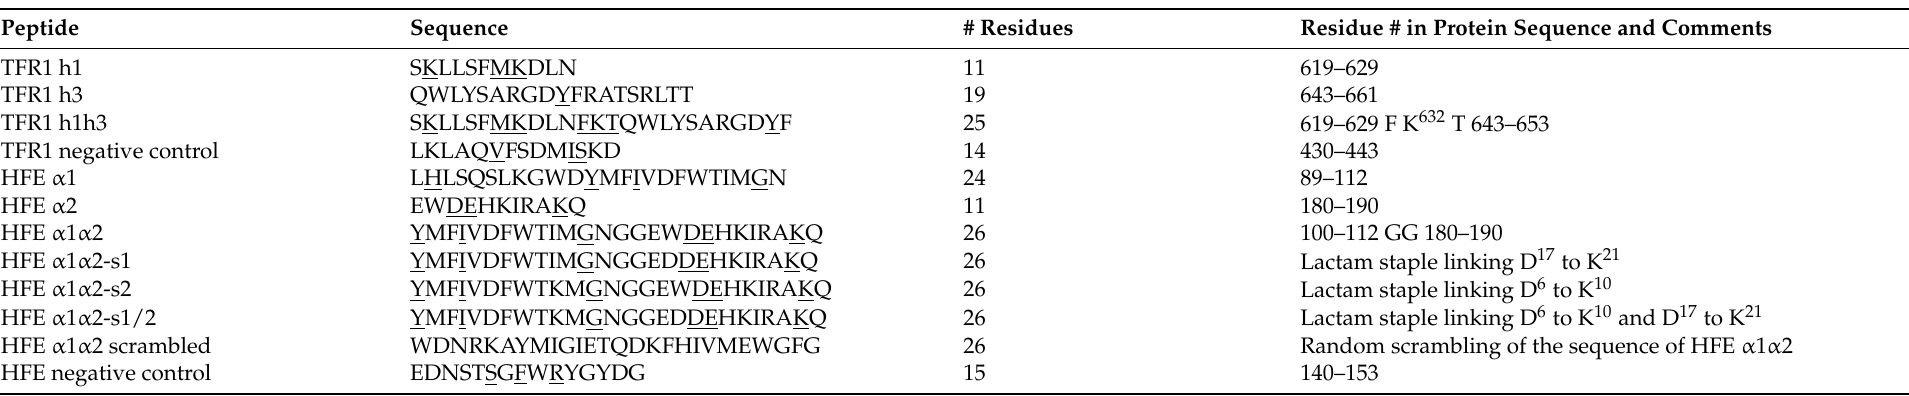
Table 1. Library of TFR1- and HFE-like peptides (based on mouse, Mus musculus , protein sequence). Amino acid differences from human, Homo sapiens , sequences are shown underlined. Sequences were written using the single-letter amino acid code. # =